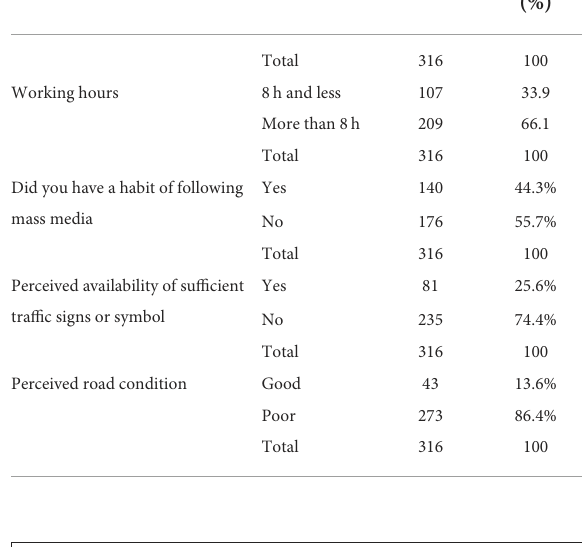
TABLE 2 Drivers and Vehicle-related characteristics of the participants in Dilla Town, Gedeo Zone, Southern Ethiopia, 2021 (n = 316). Variables Frequency Percentage